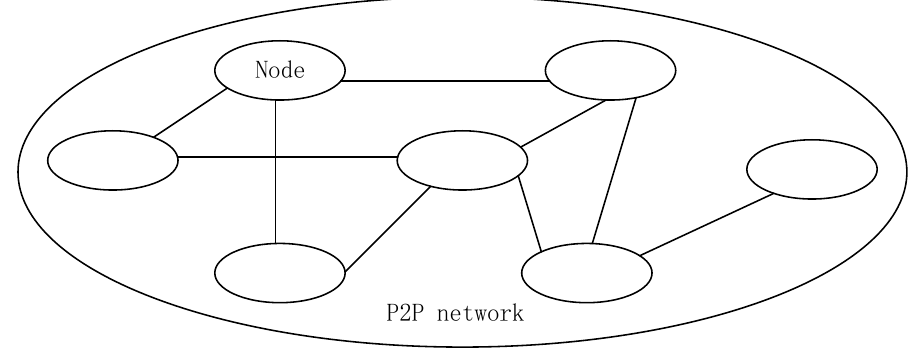
Figure 1. The structure of the P2P network.